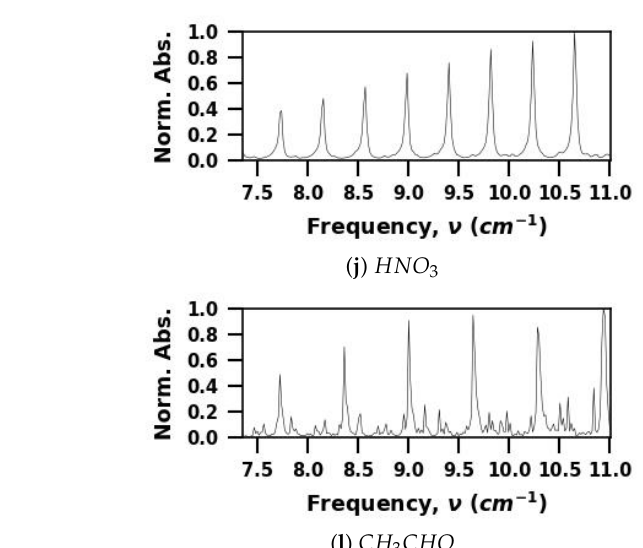
Figure 2. Representative simulated spectra; conditions: 1 Torr, 297 K, 21.6 cm